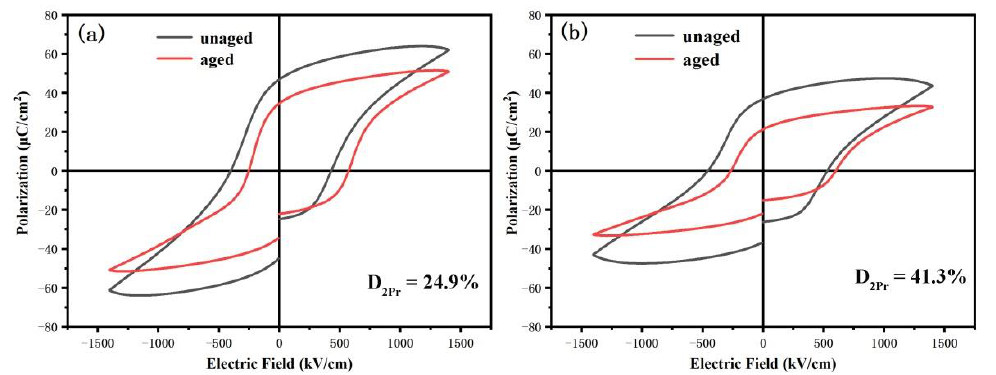
Figure 9. Comparison of hysteresis loops of the BSFM films with different Sm content measured after an interval of 110 days: ( a ) x = 4 mol%; ( b ) x = 6 mol%.